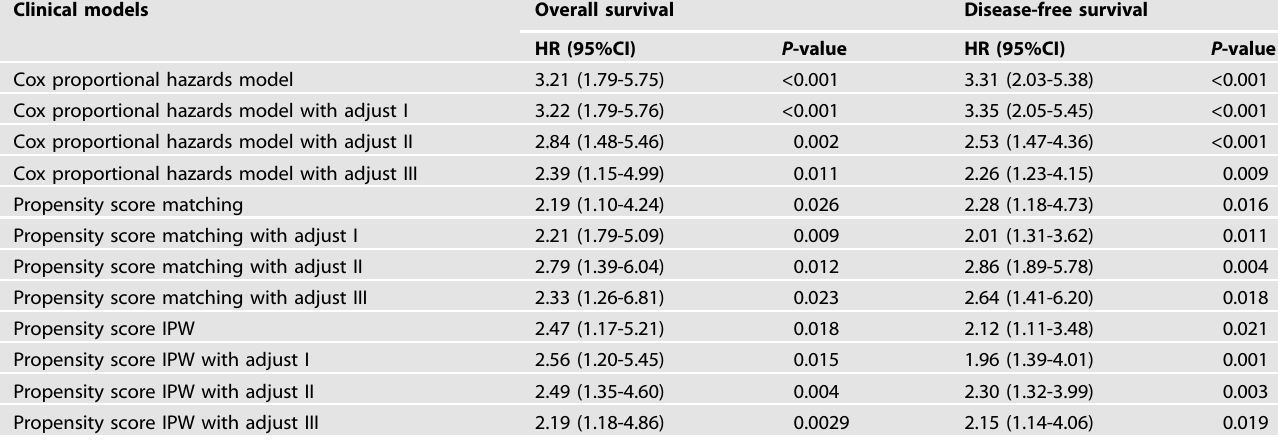
Table 2. Results of clinical outcomes and sensitivity analysis.